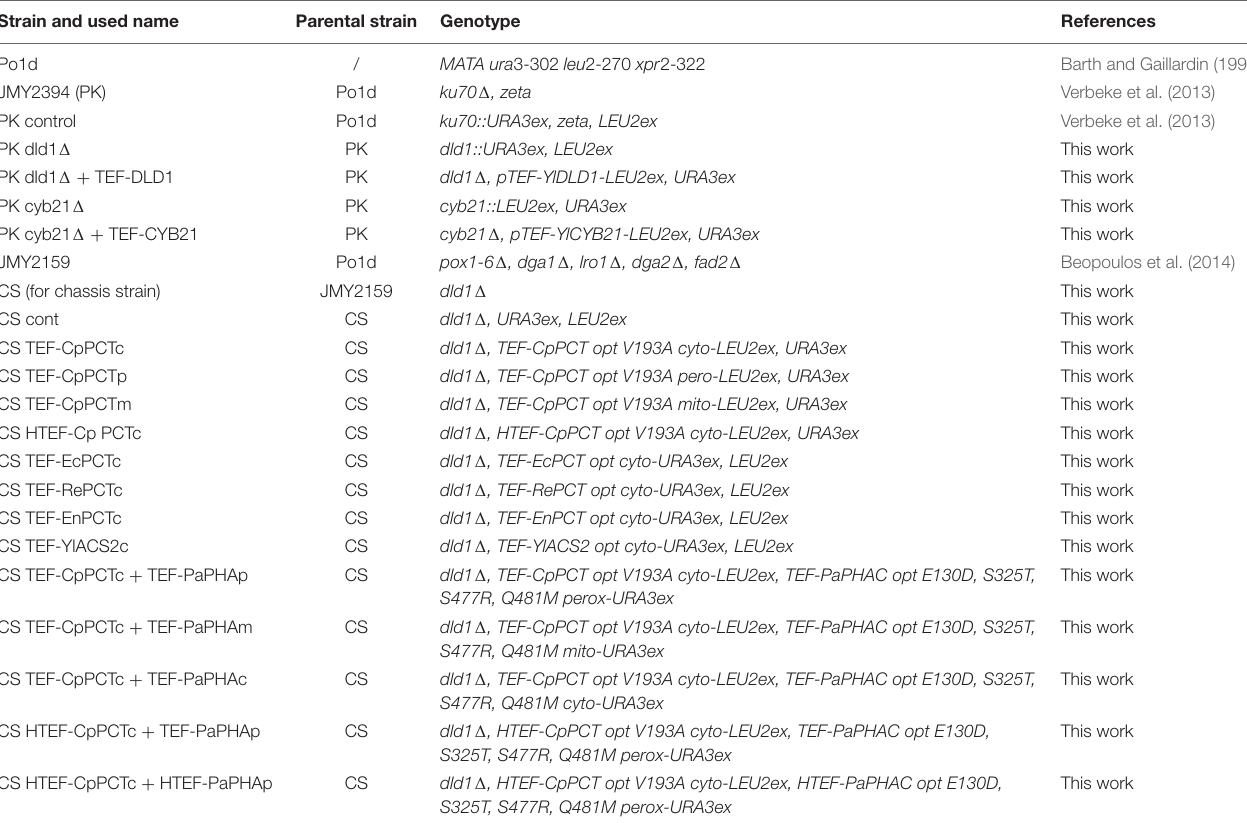
TABLE 2 | Y. lipolytica